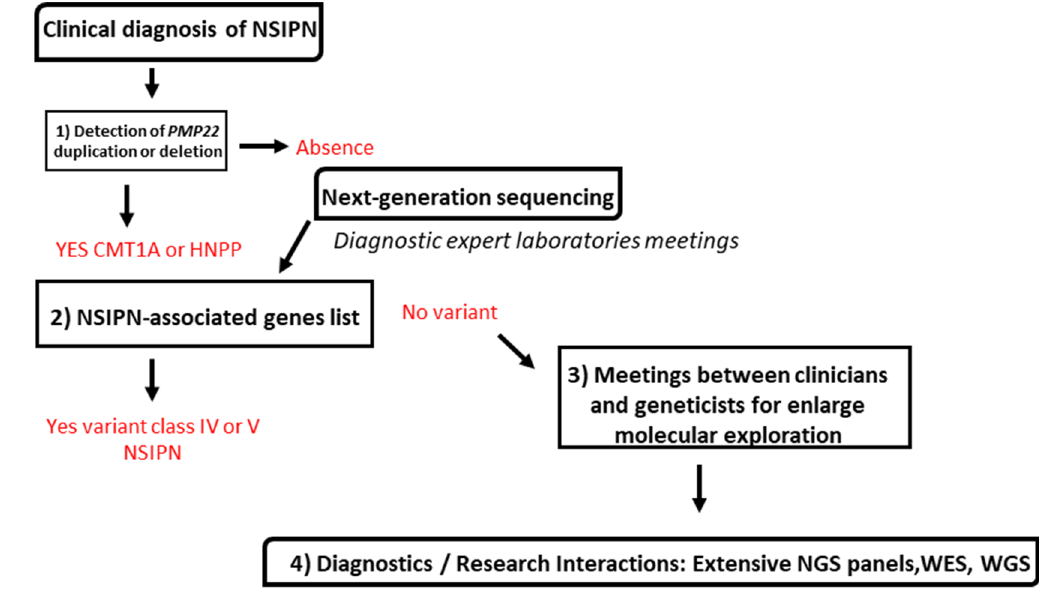
Figure 1. National French consensus strategy for genetic diagnosis of NSIPN using NGS.